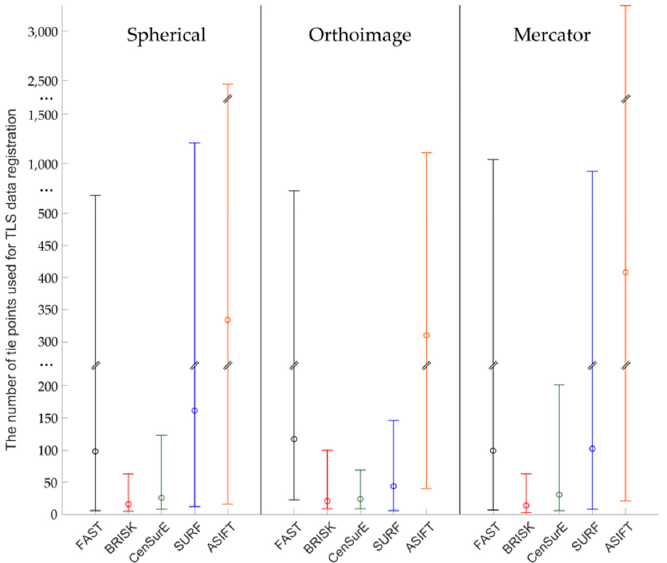
Figure 12. Diagram of the mean (circles), maximum and minimum percentage of correctly detected and matched key points using blob (ASIFT, SURF, and CenSurE) and point (FAST and BRISK) detectors for rasters in the spherical projection, orthoimages, and the Mercator projection; Test Site III.